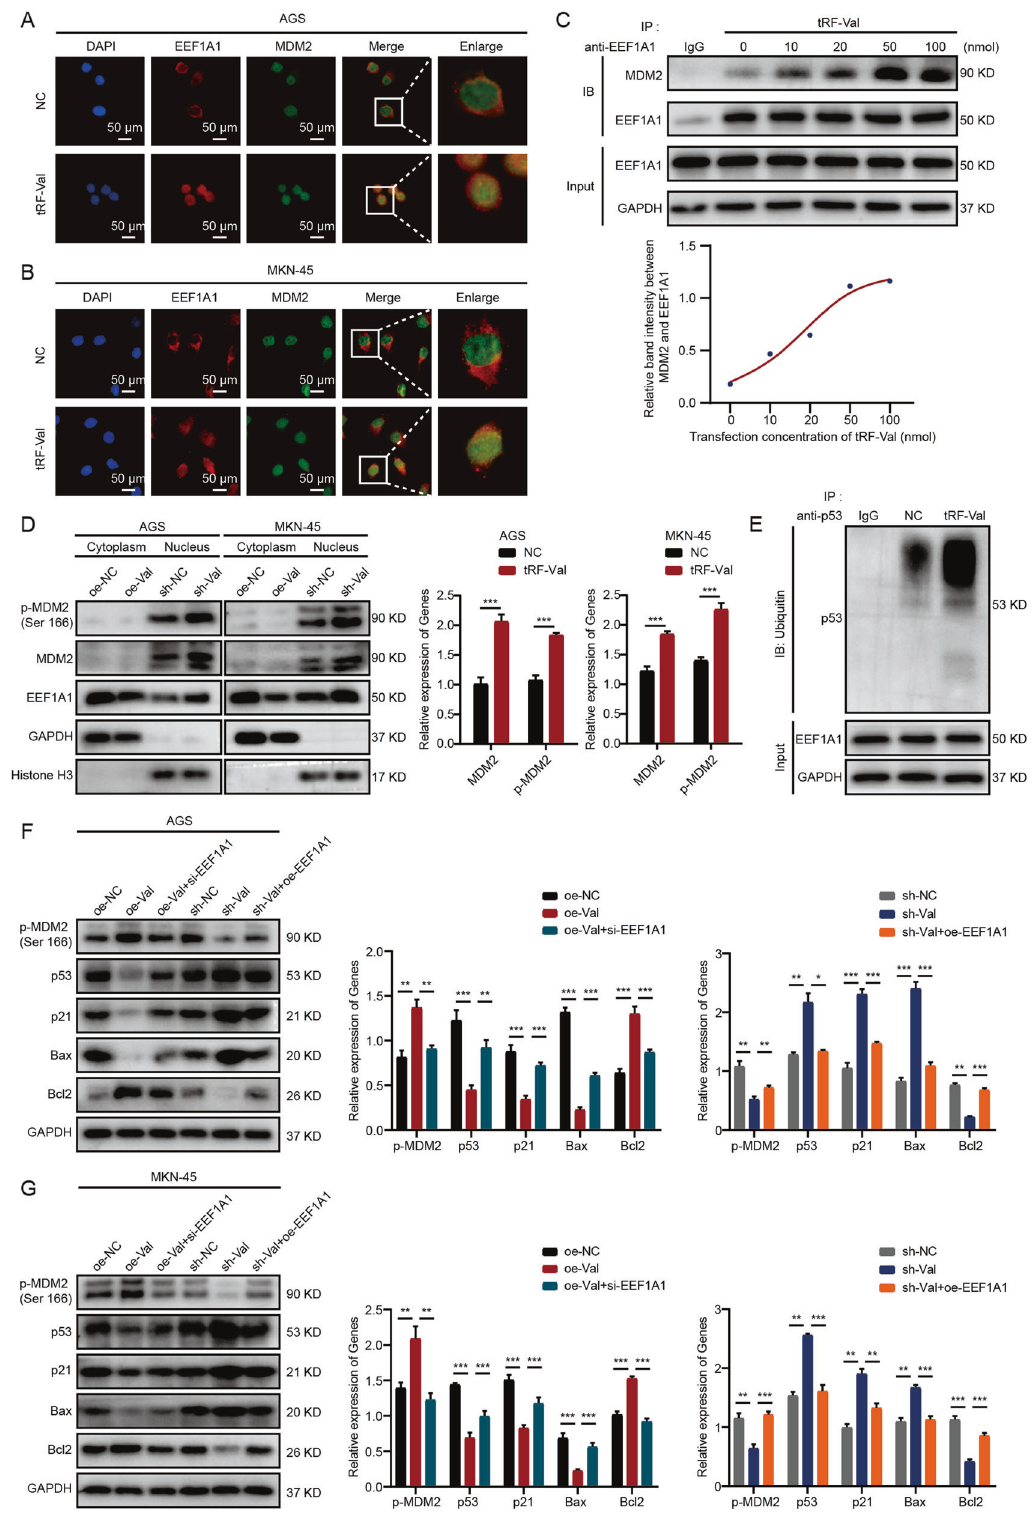
Fig. 6 tRF-Val regulates the MDM2/p53 pathway by promoting the interaction between EEF1A1 and MDM2. A , B IF assay showed that tRF- Val promoted the colocalization of EEF1A1 and MDM2 in the nucleus of AGS and MKN-45 cells. The scale bar, 50 μ m. C Co-IP assay showed that the amount of MDM2 co-immunoprecipitated by anti-EEF1A1 antibody increased in a gradient with the increase of tRF-Val transfection concentration in AGS cells. D WB assay proved that tRF-Val overexpression signi fi cantly promoted the nuclear localization of MDM2 and p-MDM2. E tRF-Val overexpression signi fi cantly promoted the ubiquitination of p53. F , G WB rescue experiments showed that the regulatory effect of tRF-Val on p-MDM2 and its downstream target molecules could be reversed by the knockdown and overexpression of EEF1A1 in AGS and MKN-45 cells. Data were shown as mean ± SD. (Student ’ s t -test, * P < 0.05, ** P < 0.01, and *** P < 0.001).